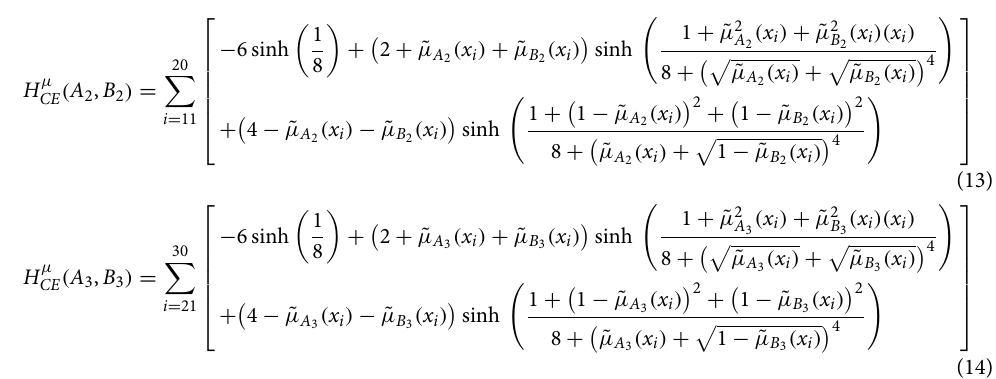
Figure 3. The suggested procedure for the distinction and taxonomy of